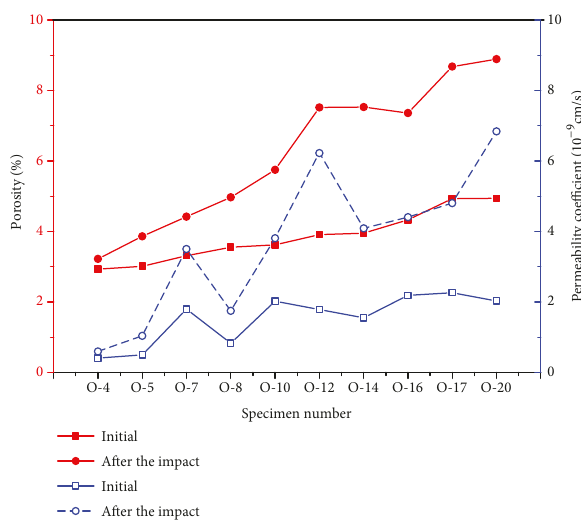
Figure 12: Change of porosity and permeability coe ffi cient before and after impact of weakly weathered